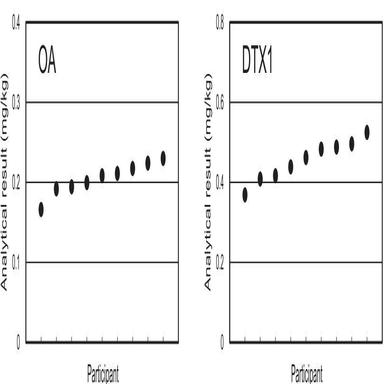
Analytical results of OA and DTX1 obtained in the co-laboratory study for characterization of CRM 7520-a.